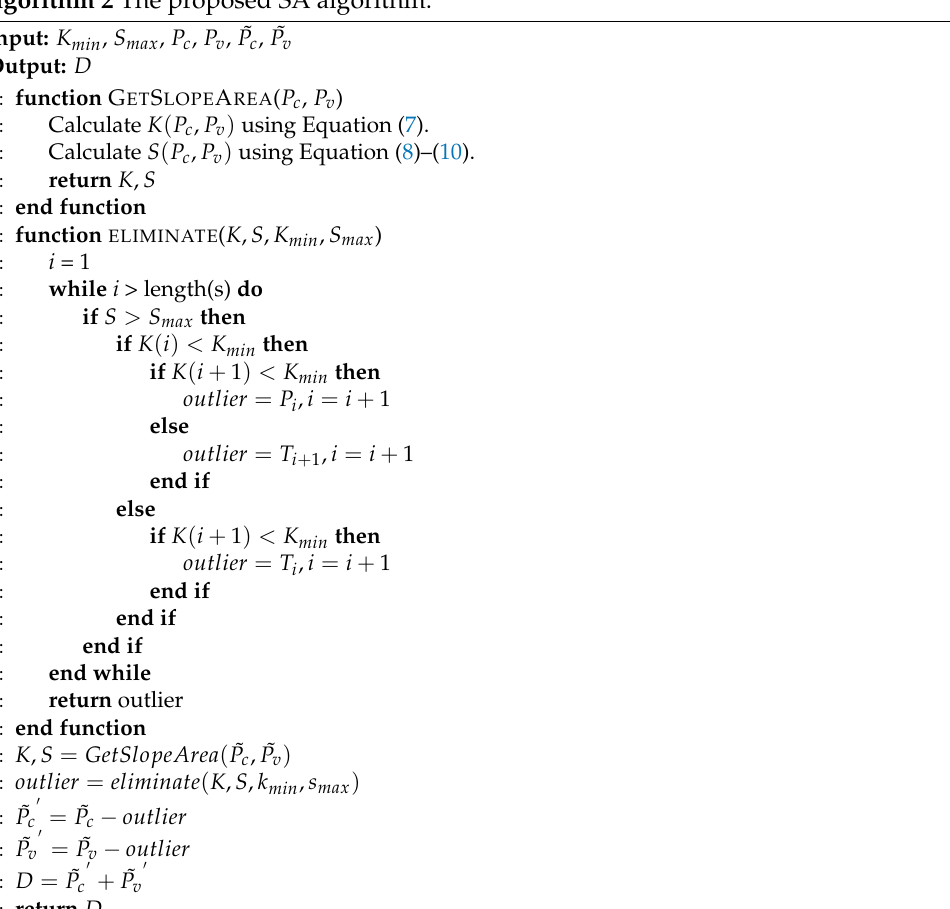
Algorithm 2 The proposed SA